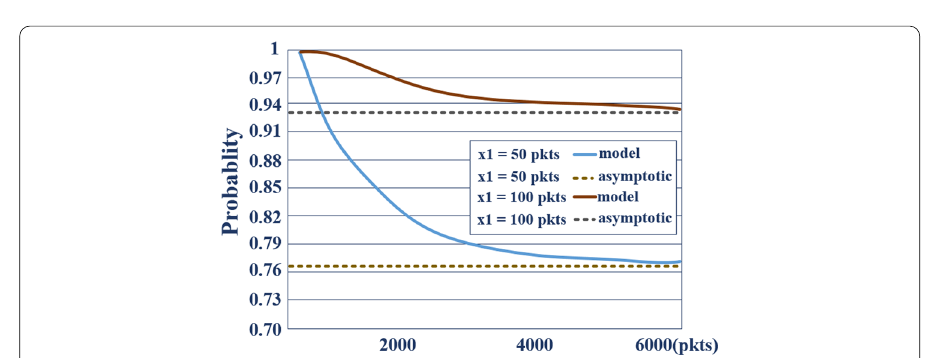
Fig. 7 Asymptotic probability of no